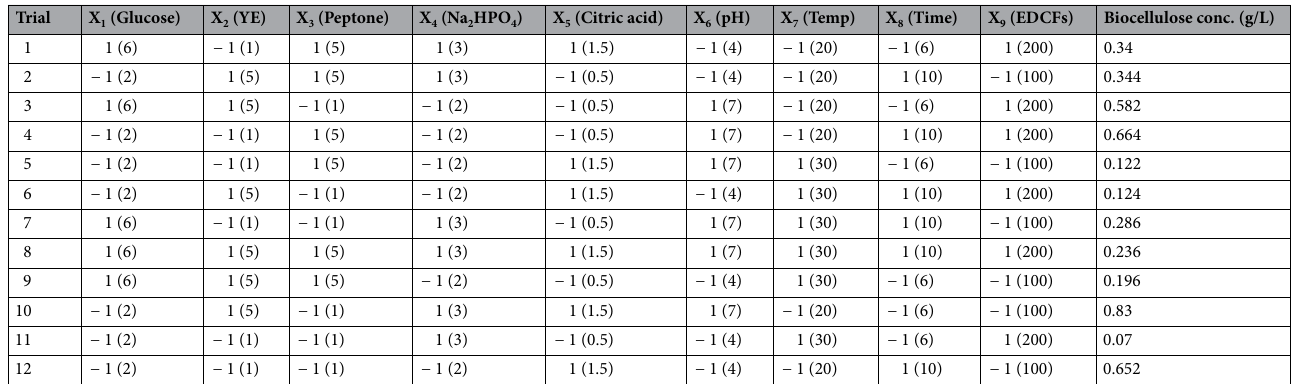
Table 1. PB experimental design for evaluating factors influencing on biocellulose concentration produced by Komagataeibacter hansenii AS.5 using EDCFs as a carbon and nitrogen source. Levels of independent variables (X1–X9) presented between brackets are expressed in terms of g/L for X1-X5, value for X6-X8 and volume (ml/L) for X9. − 1 and + 1 constitute the low level and high level and cellulose conc. expressed as